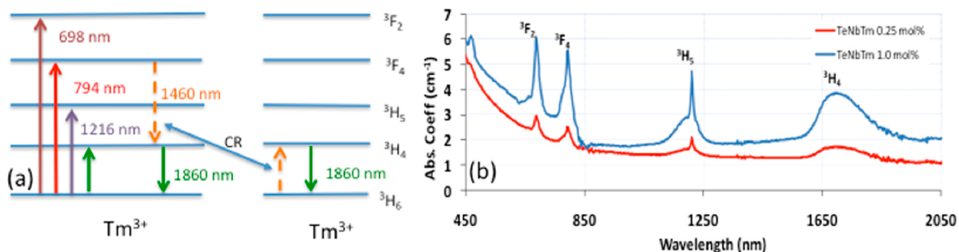
Figure 1. ( a ) Energy level diagram of the Tm 3+ ion. CR: Cross-relaxation ( b ) Absorption spectra of two Tm 2 O 3 : TeO 2 -Nb 2 O 5 glass samples with Tm 2 O 3 concentrations of 1.0 and 0.25 mol % in the range of 450–2050 nm. The corresponding absorption bands from the ground state ( 3 H 6 ) are indicated. Table 1. Judd–Ofelt (J-O) intensity parameters for three different glass hosts with 1 mol % Tm ion concentration.